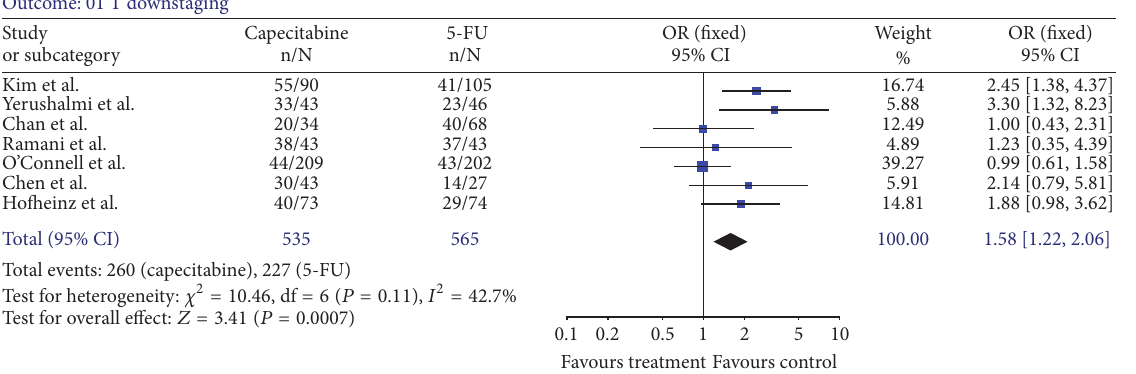
Figure 4: Forest plot of odds ratio (OR) for T downstaging rate.